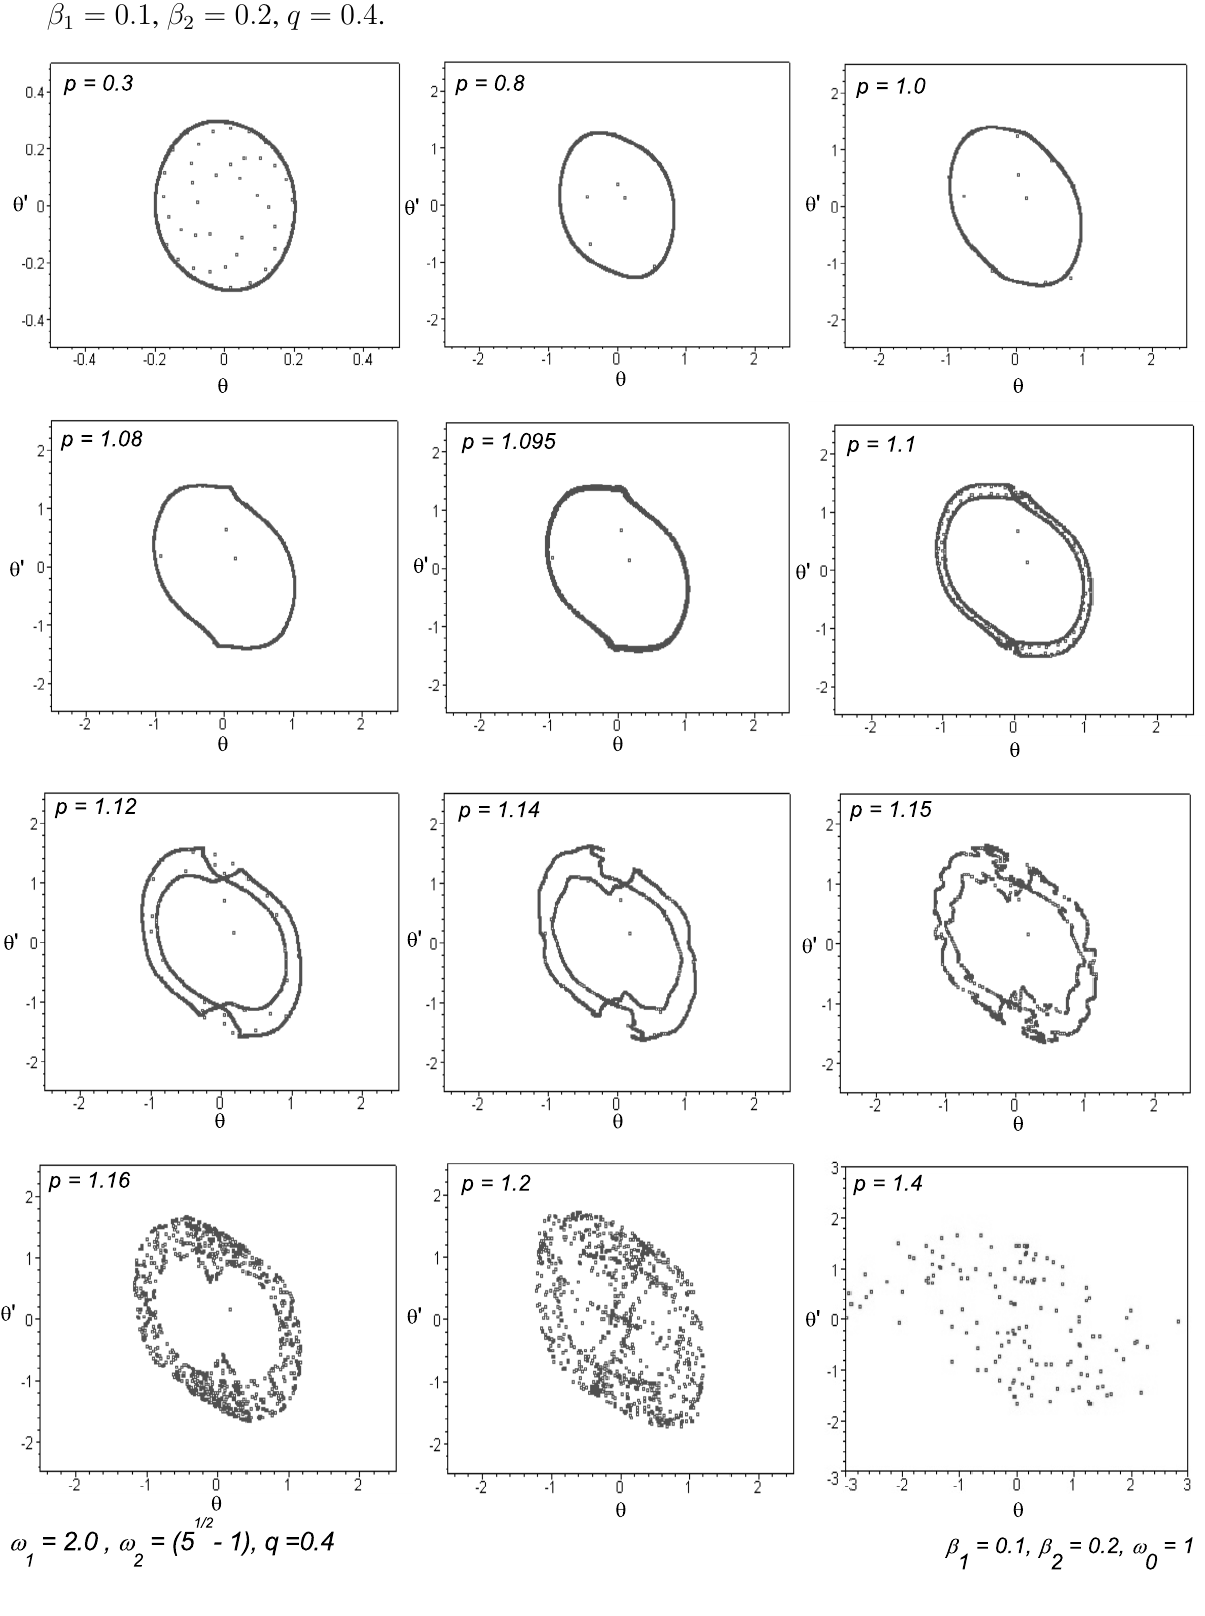
Figure 10. Poincaré sections stroboscopically sampled at a period equal to 2 π of forcing amplitude p -values at the control parameters ω β = 0 . 1 , β = 0 . 2 , q = 0 . 4 1 2